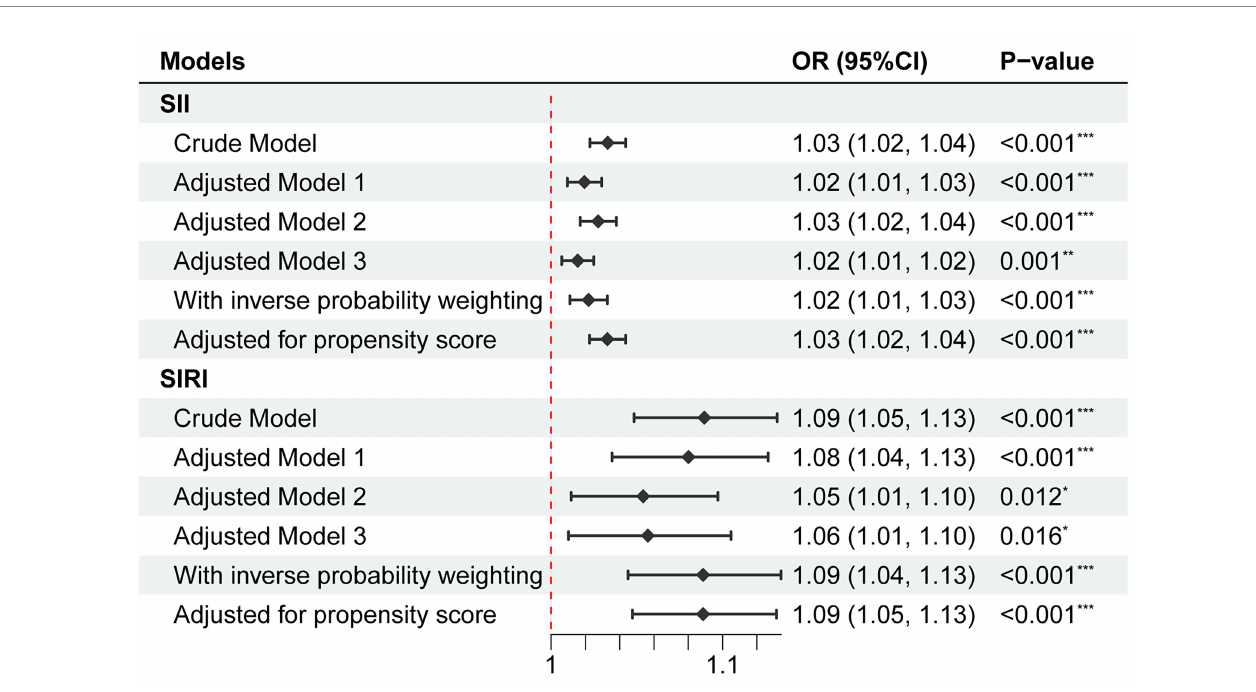
FIGURE 2 Association of SII and SIRI with depression risk. No adjustment was done in the crude model. Model 1 adjusted for age, gender, ethnicity, education level, family income, education level, marital status, BMI, and CCI. Model 2 adjusted for smoking status and alcohol use. Model 3 adjusted for age, gender,